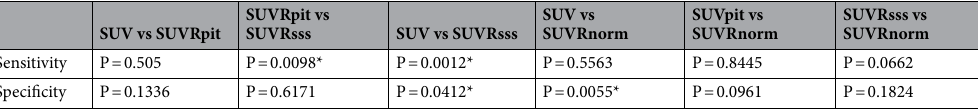
Table 10. The McNemar’s Test for sensitivity/specificity of the four methods at the optimal thresholds.